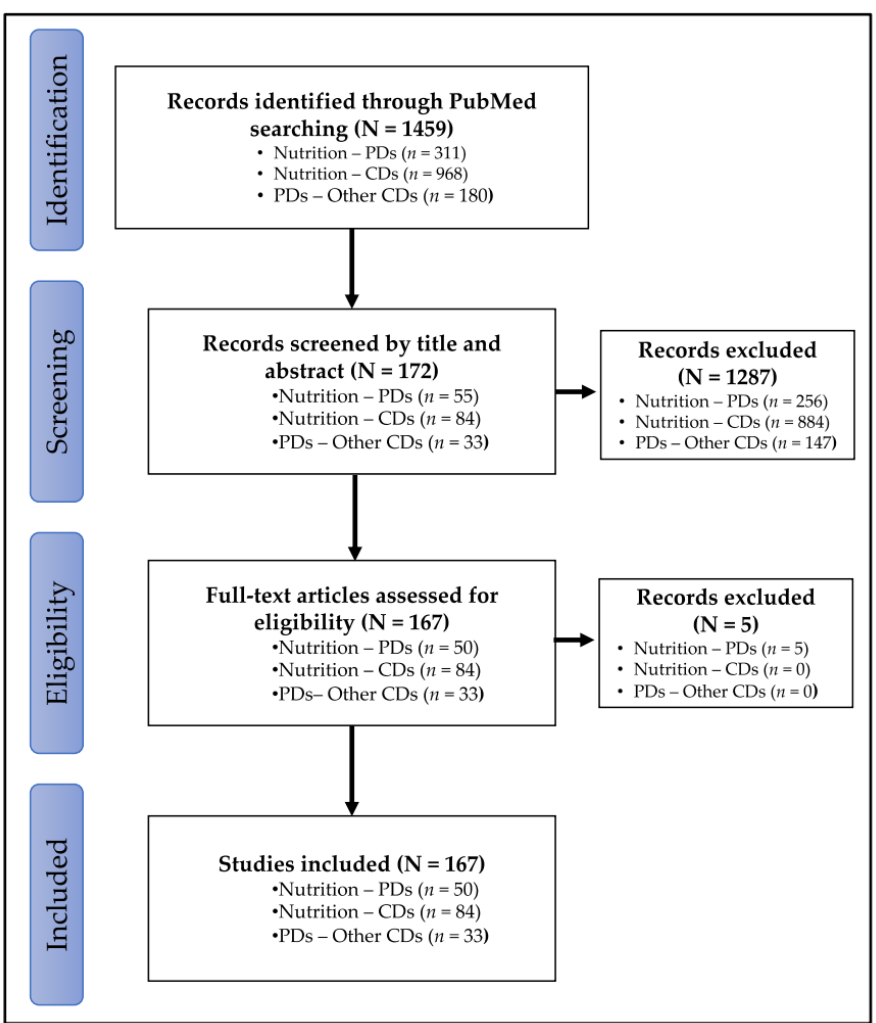
Figure 1. Flowchart of study selection process. CDs: chronic diseases; PD: periodontal